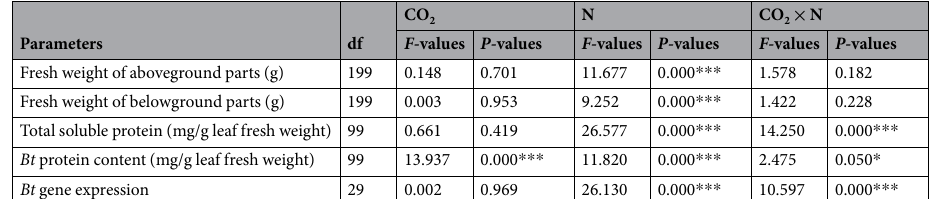
Table 4. F-values and P-values from two-way ANOVA for the effects of CO 2 levels and N levels on the fresh weight of rice plants, total soluble protein, Bt toxin content, and Bt gene expression. * P < 0.05; *** P < 0.001.